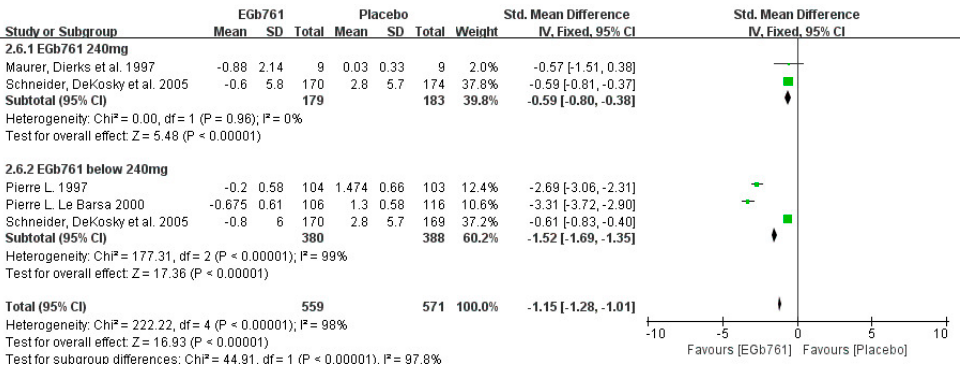
Figure 7. Forest plot of comparison: meta-analysis of AD patients taking either placebos or GBE in SKT, at doses of 240 mg/d, and below 240 mg/d. The square area represents the weight assigned to the study in the meta-analysis. The horizontal line represents the 95% confidence interval.